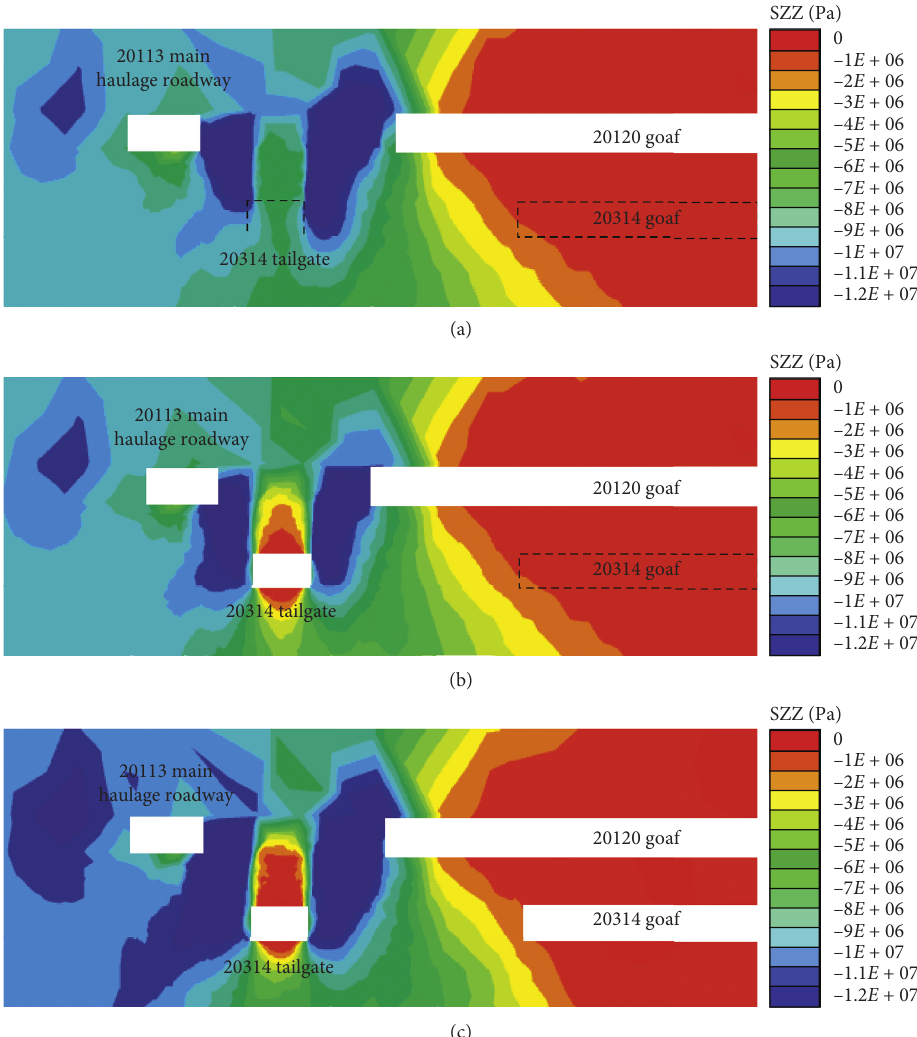
Figure 17: Nephogram of stress perpendicular to the section auxiliary haulage roadway (perpendicular to the axis section of the roadway): (a) 2-2 upper coal seam excavation; (b) 20314 tailgate excavation; (c) 20314 panel